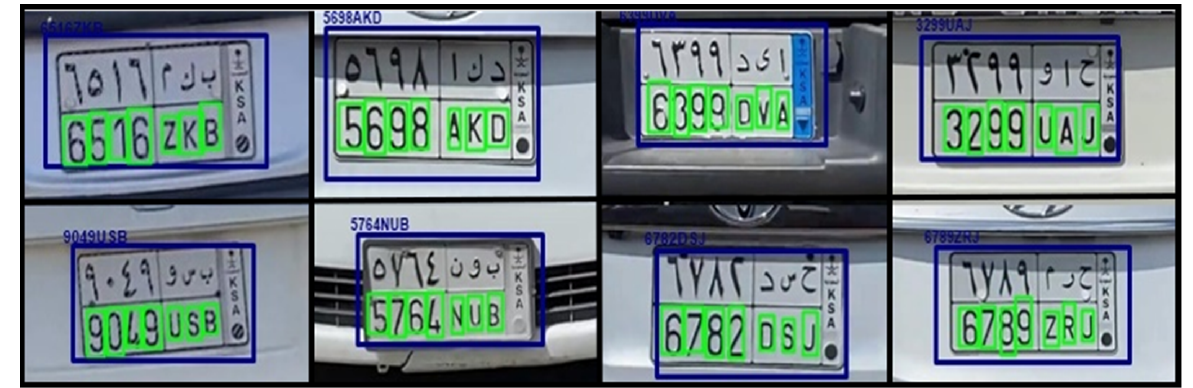
Figure 21. Recognition results of parking lot-based LPs.